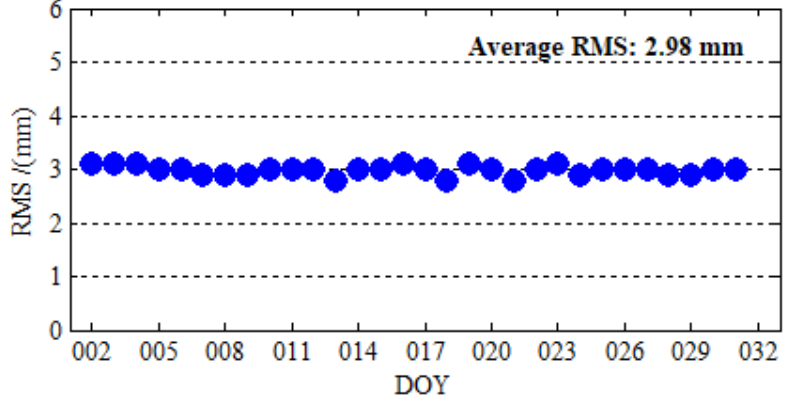
Figure 11. Time series of the RMS between iGMAS ZTD and IGS ZTD products from 2 January 2019 to 31 January 2019.